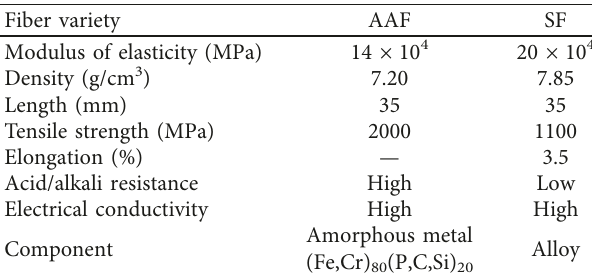
Table 4: Properties of AAF and SF.